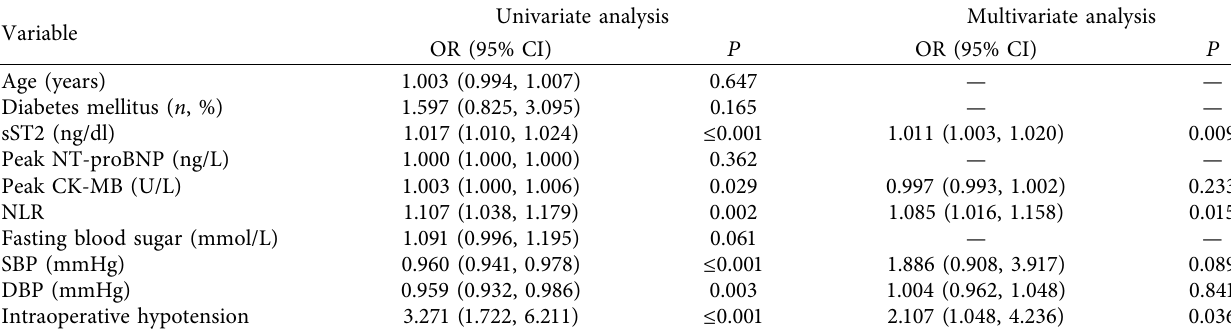
Table 3: Multivariate logistic regression analysis for potential predictors of